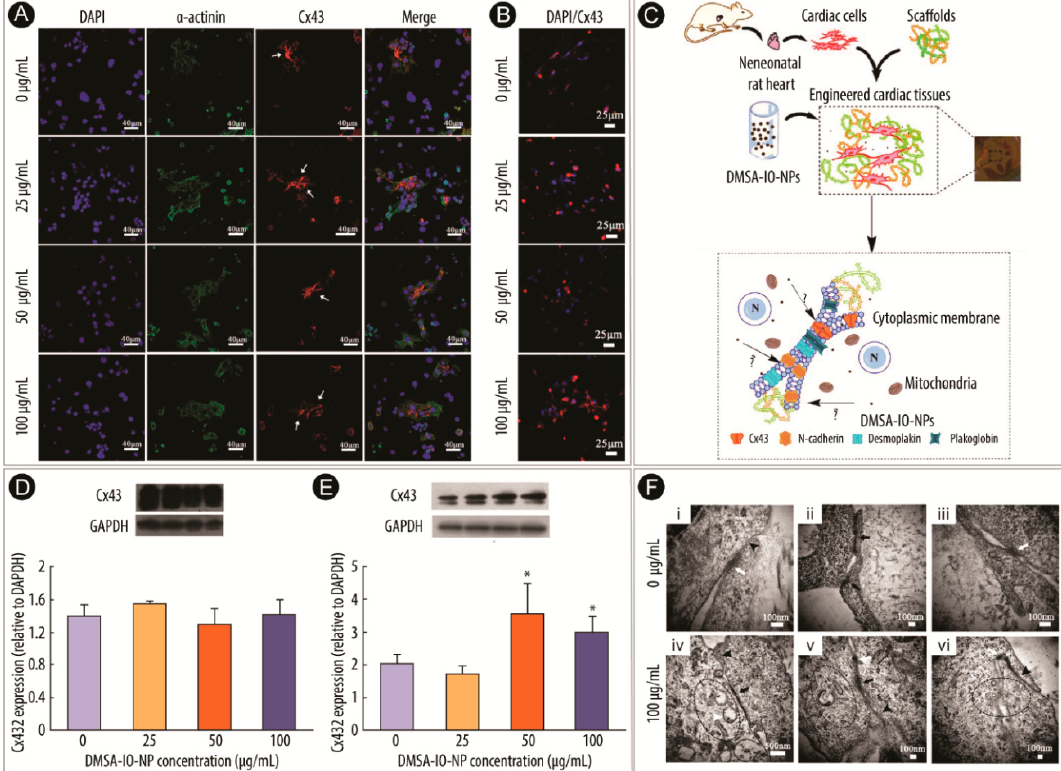
Figure 2. The effect of 2,3-dimercaptosuccinic acid-modified iron-oxide nanoparticles (DMSA-IO-NPs) in cardiac tissue engineering. Immunofluorescence staining of α -actinin (green), connexin 43 (Cx43, red), and nuclei (4 ′ ,6-diamidino-2-phenylindole (DAPI), blue) of cardiomyocytes under different concentrations of DMSA-IO-NP in a two-dimensional (2D) ( A ) and three-dimensional (3D) ( B ) culture. In ( A ), the arrows indicate the Cx43 distribution in cell–cell interfaces. Western blotting of Cx43 levels of cardiomyocytes under different concentrations of DMSA-IO-NP in a 2D ( D ) and 3D ( E ) culture, with glyceraldehyde 3-phosphate dehydrogenase (GAPDH) expression as an internal control; * p < 0.05 vs. 0 µg/mL. TEM imaging of gap junctions (black arrowhead), adherent junctions (white arrows), desmosomes (black arrows), and vesicle domain (dotted area) in the engineered cardiac tissues (ETCs) with different concentrations of DMSA-IO-NPs ( F ). Schematic representation of the construction of ECTs and the evaluation of the effect of DMSA-IO-NPs on cardiomyocytes ( C ). For ( A ) and ( D ), reprinted with permission from Reference [65]. Copyright 2015, Royal Society of Chemistry. For ( B , C,E , F ), reprinted with permission from Reference [66]. Copyright 2016, John Wiley and Sons.